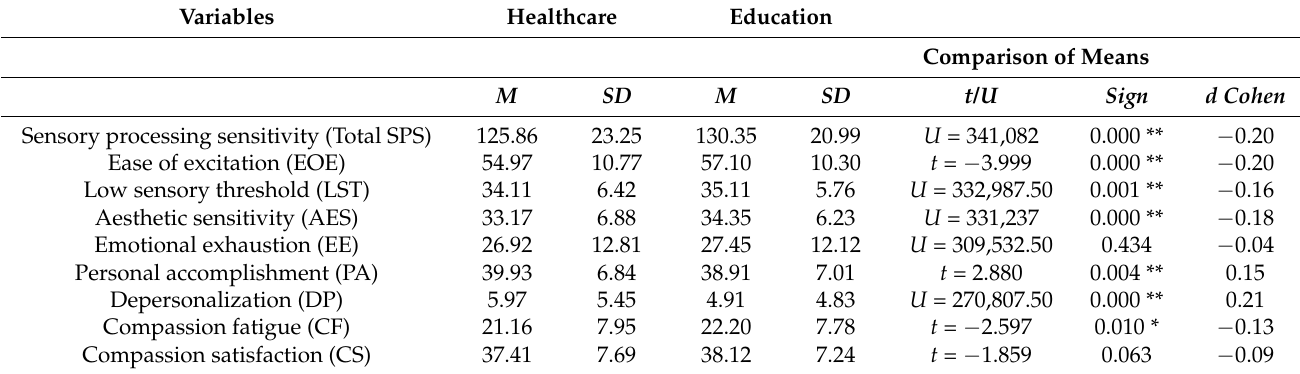
Table 2. Comparisons between